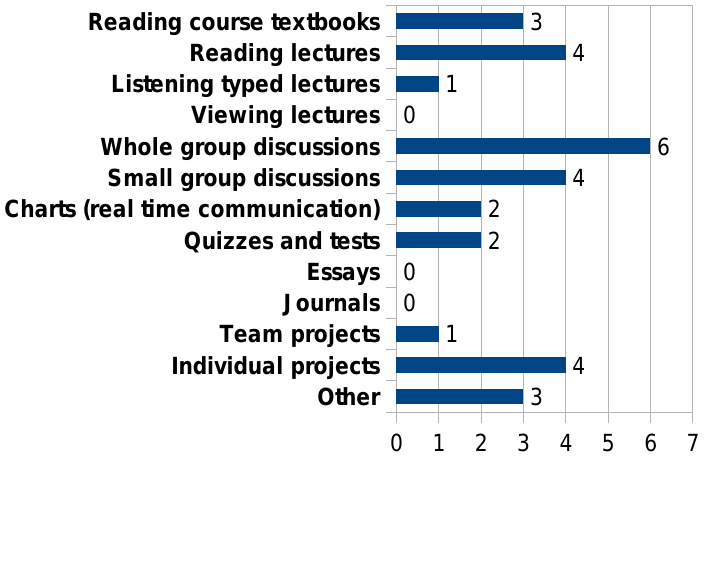
Figure 2 . Question 7 results. 1